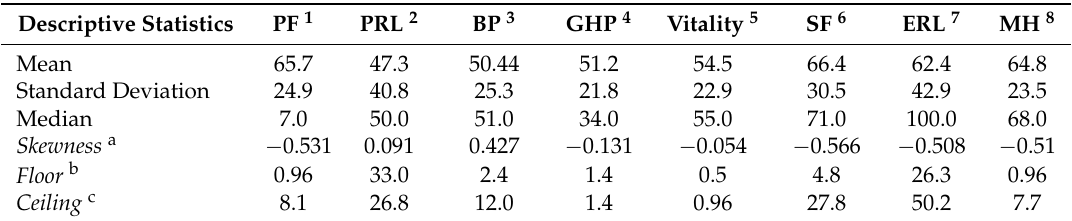
Table 3. Descriptive statistics of the SF-36v01 domains of artisanal fisherwomen/shellfish gatherers from the municipality of Saubara, Bahia, Brazil, 2013.